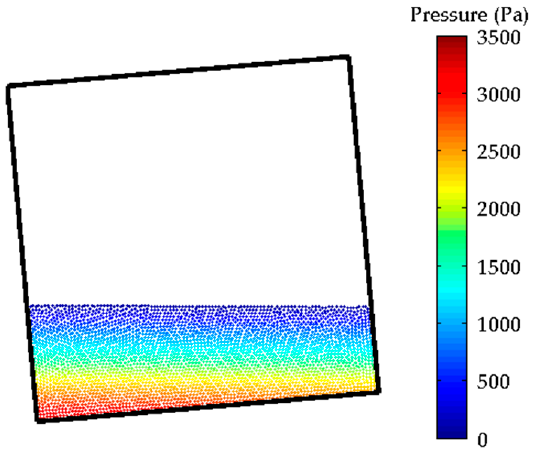
Figure 19. Flow pattern and pressure distribution in the SPH simulation ( h = 1.33 ∆ x , ω = 0.95 rad/s, t = 11.57 s )